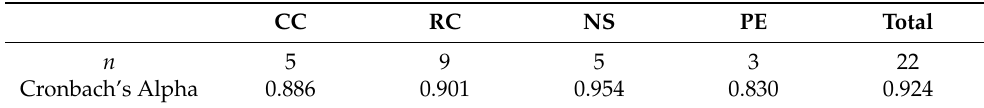
Table 3. The internal consistency.